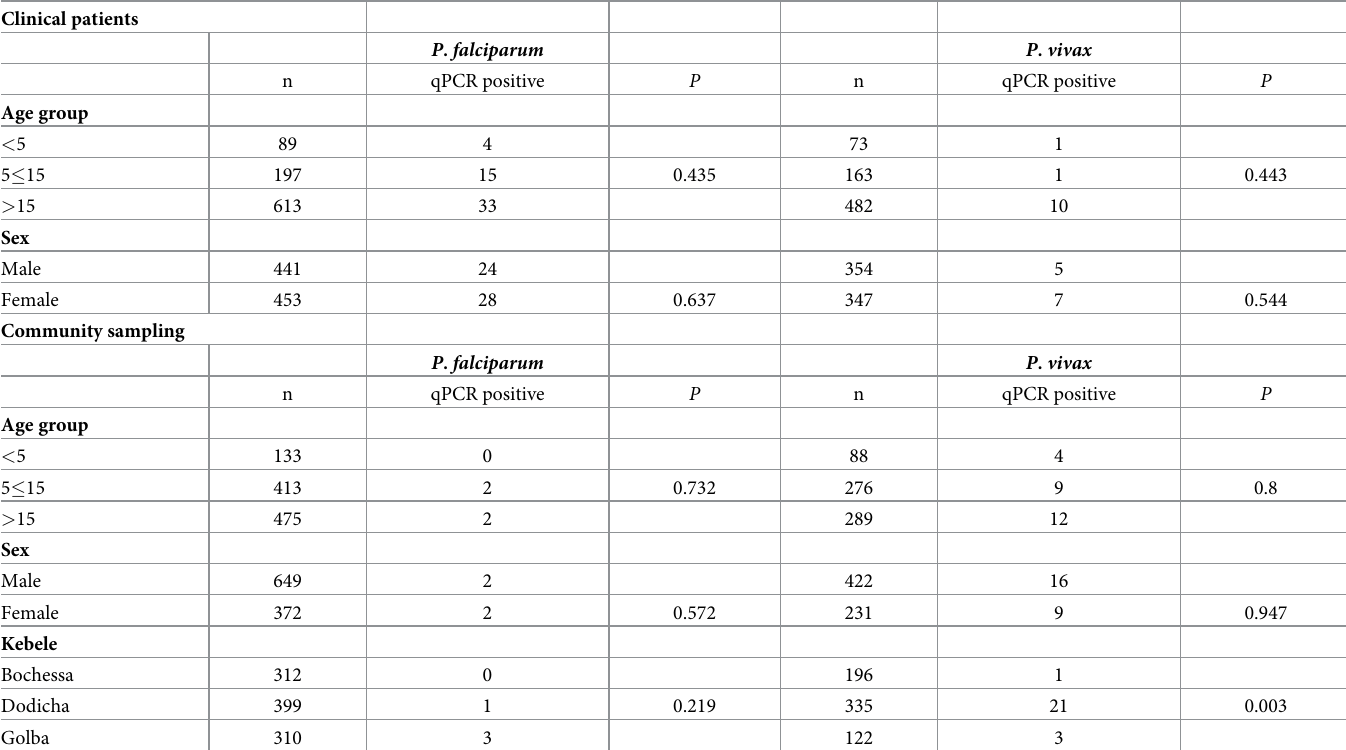
Table 2. Demographic and qPCR data of study